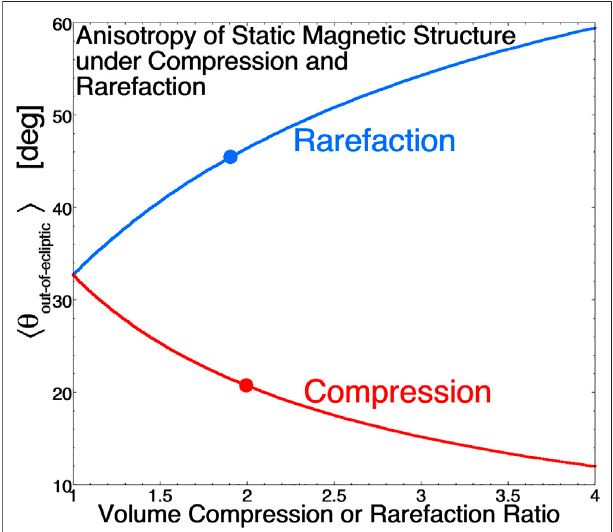
FIGURE5| Forpurelycylindrical(circular) fl uxtubesinthesolarwind,the meananglebetweenthe fl ux-tube-wallnormaland theeclipticplaneisplotted as a function of the volume compression ratio (red curve) and as a function of the volume rarefaction ratio (blue